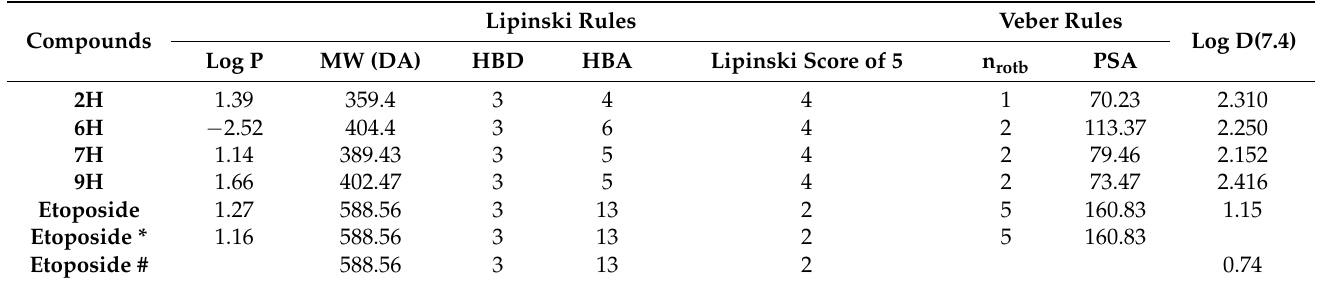
Table 6. Computed pharmacological activities and properties using multi parameter optimization (MPO) method for the four TUDHIPP derivatives ( 2H , 6H , 7H , and 9H ). Lipinski